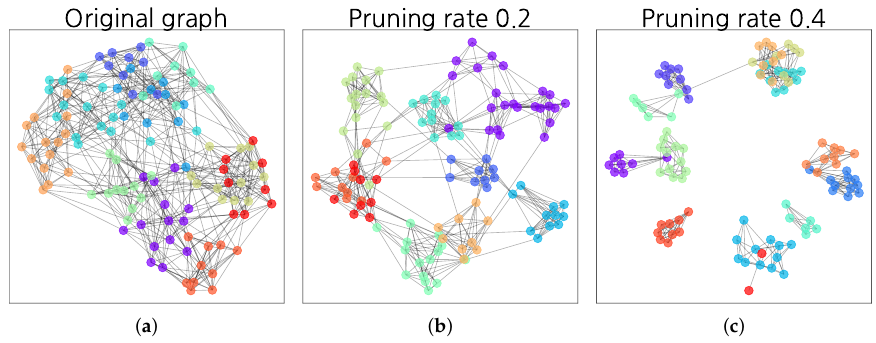
Figure 3. Graph sparsification after link pruning with Jaccard’s index: ( a ) pruning rate 0 (original graph); ( b ) pruning rate 0.2; and ( c ) pruning rate 0.4.